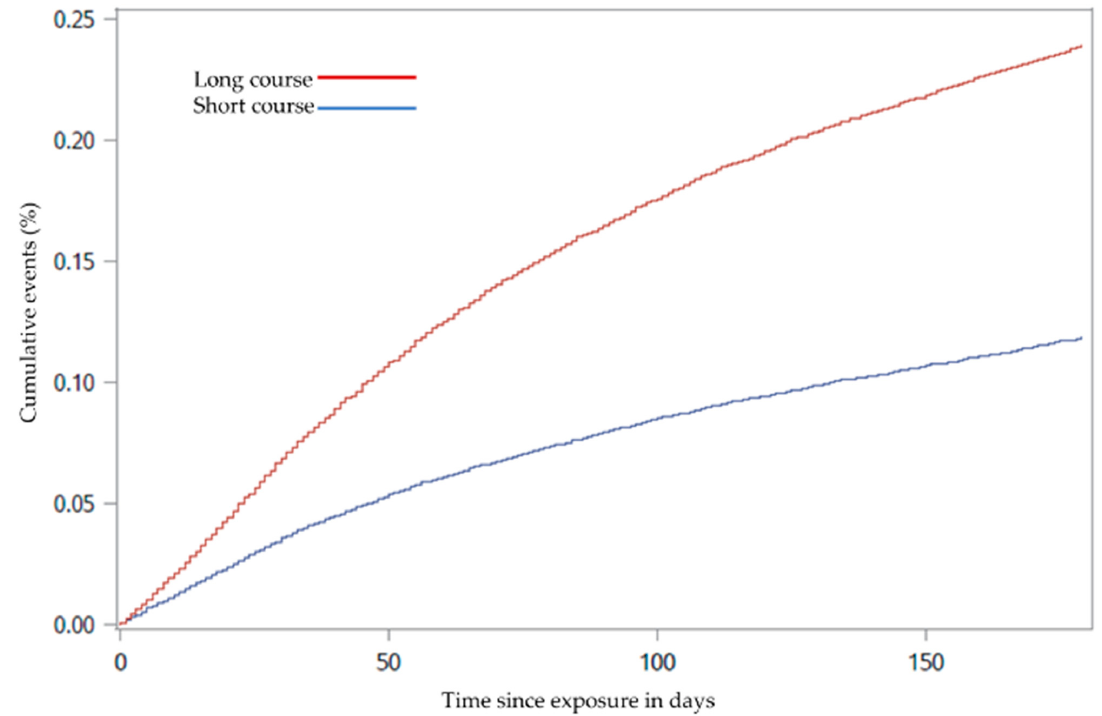
Figure 3. Cumulative incidence curve for all-cause mortality from baseline until the first event within the 6-month follow-up period among chronic obstructive pulmonary disease outpatients treated with long vs. short oral corticosteroid treatment courses from 2010 to 2018 ( p < 0.0001).